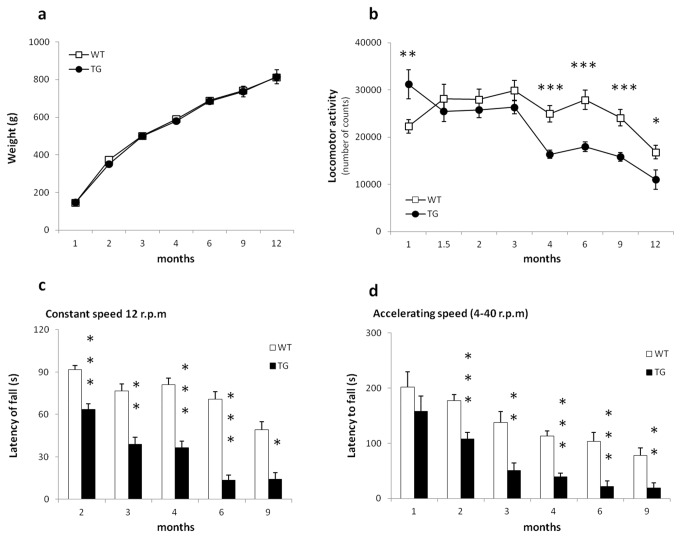
Phenotype.Results are expressed as Mean ± SEM. (a) Body weight. There is no significant difference between TG and WT control rats. (b) Locomotor activity. Compared to WT, TG rats have a higher total activity at one month followed by a lower activity starting at 4 months of age. (c-d) Rotarod. Presented are the latency to fall off the rod during (c) constant speed (12 r.p.m) and (d) accelerating speed (4 - 40 r.p.m). A significant difference between groups was present already at 2 months of age [constant speed (2 months: t= 3.373, P< 0.001; 3 months: t= 3.53, P< 0.01; 4 months: t= 4.798; P< 0.001; 6 months: t=5.433; p< 0.001 and 9 months: t= 2.742, P< 0.05); accelerating speed (1 month: t= 1.066, P> 0. 1; 2 months: t= 4.172, P< 0.001; 3 months: t= 3.549, P< 0.01; 4 months: t= 6.493, p< 0.001; 6 months: t= 4.263, P< 0.001 and 9 months: t= 3.015, P< 0.01)]. Asterisks indicate significant differences between WT and TG rats (*p < 0.05; **p < 0.01 and ***p < 0.001).